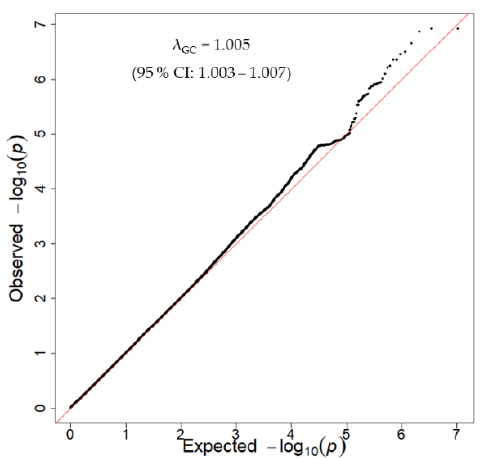
Figure 2 . Quantile-quantile plot for the discovery GWAS. The x -axis and y -axis show the theoretical –log 10 p -value and the observed –log 10 p -value, respectively. The red line represents y = x. CI: confidence interval, GWAS: genome-wide association study.